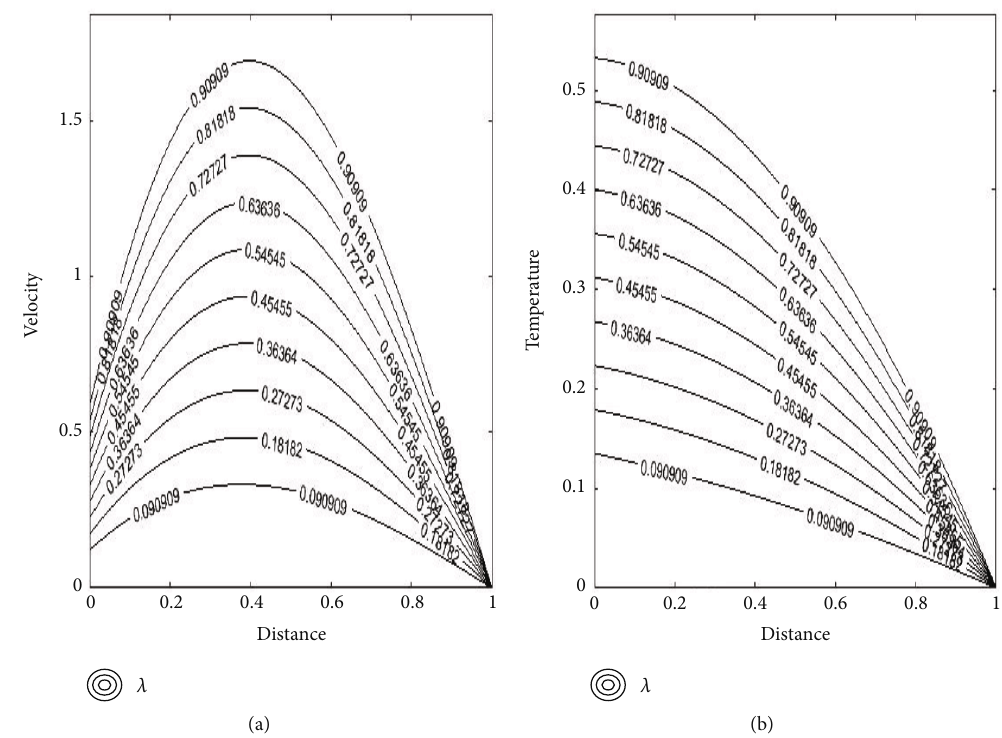
Figure 2: Velocity and temperature in a steady position for λ